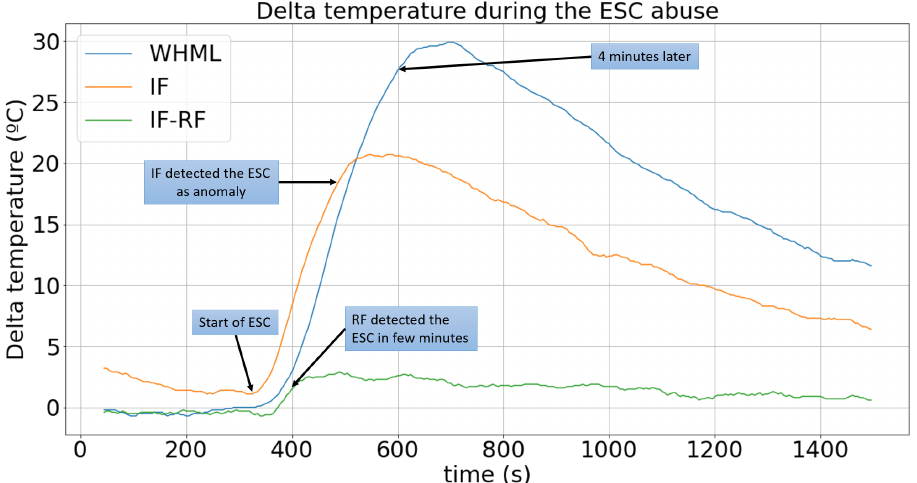
Figure 14. The behavior of the delta temperature under the ESC abuse experiments without ML and with the IF and RF. The combination of the IF-RF could avoid the increasing temperature in the cell. The temperature with the IF was raised until the anomaly detection model could identify